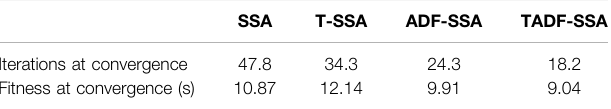
TABLE 5 | Average of convergence after 10 runs of the four algorithms at the terminal of Intel(R) i7-9750H CUP@ 2.60 GHz.